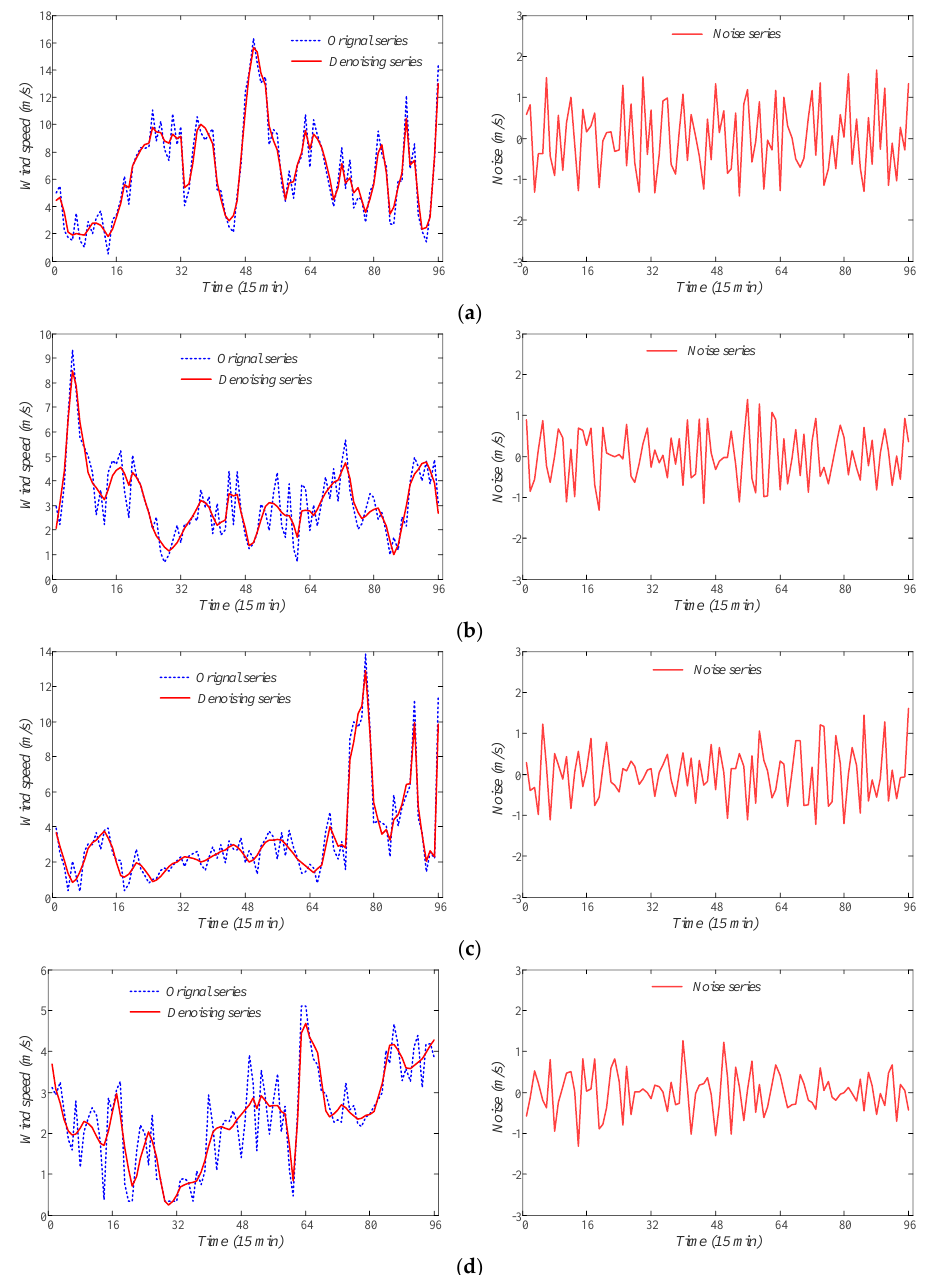
Figure 9. The denoising results of wind speed series using WTD. ( a ) 1 March 2016; ( b ) 1 June 2016; ( c )